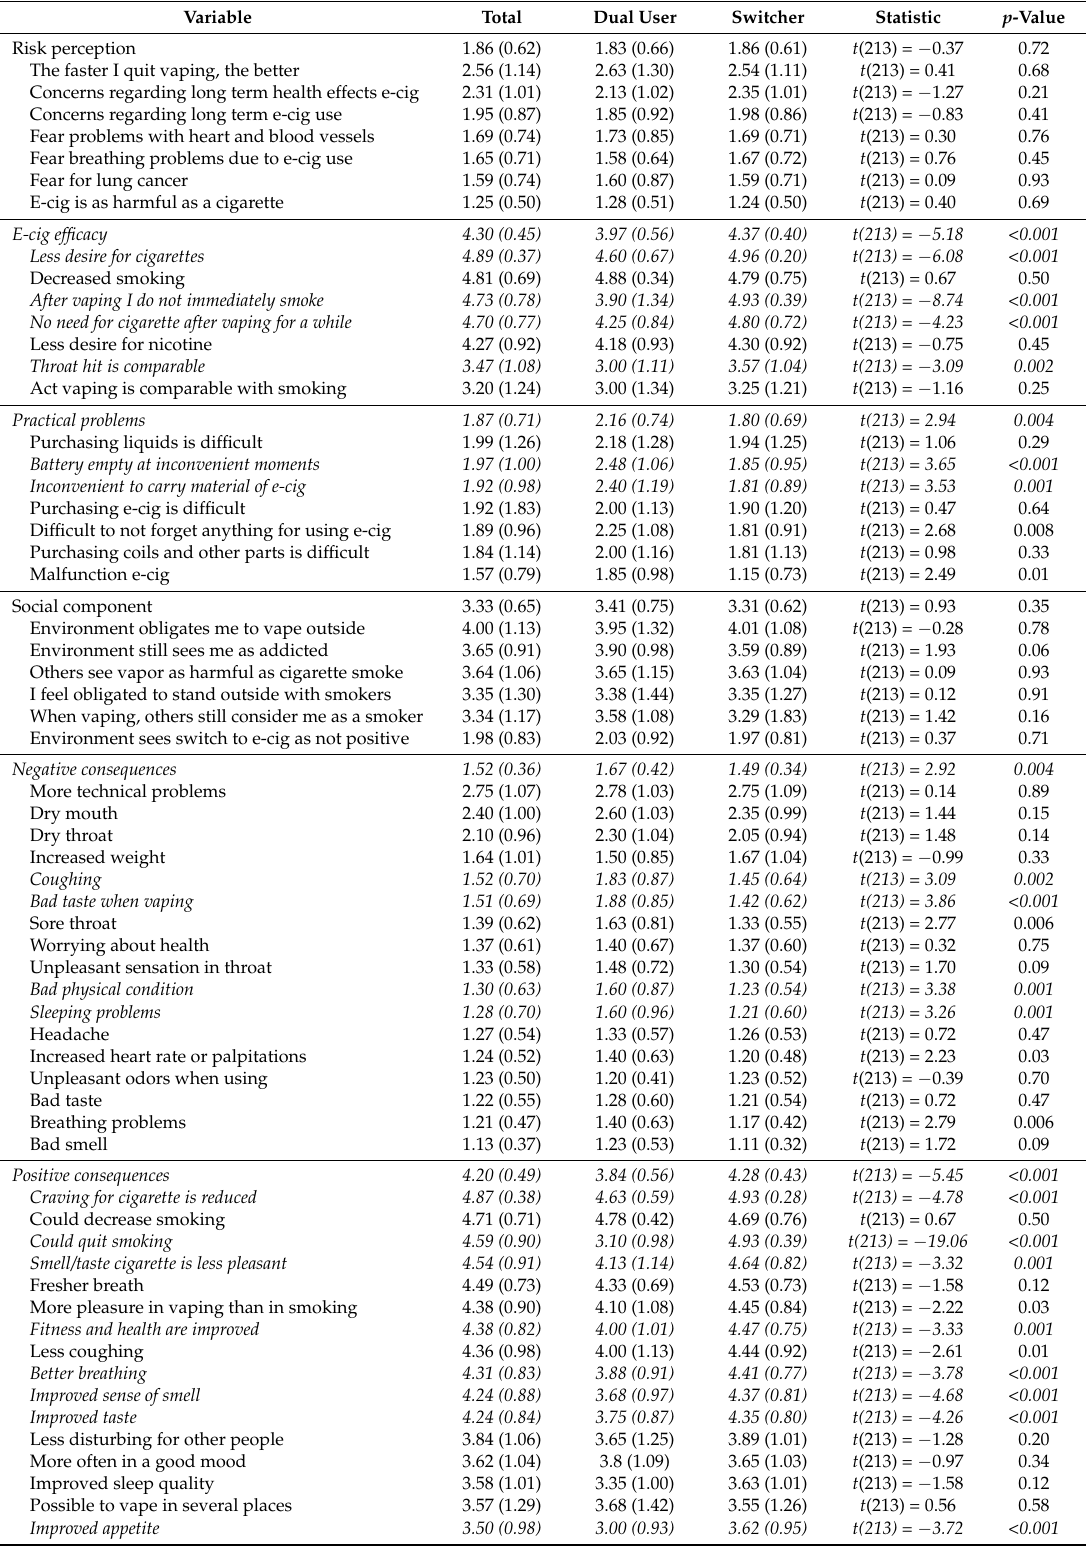
Table 4. Risk perception, e-cig efficacy, practical problems, social component, negative and positive consequences, ‘addiction’ to